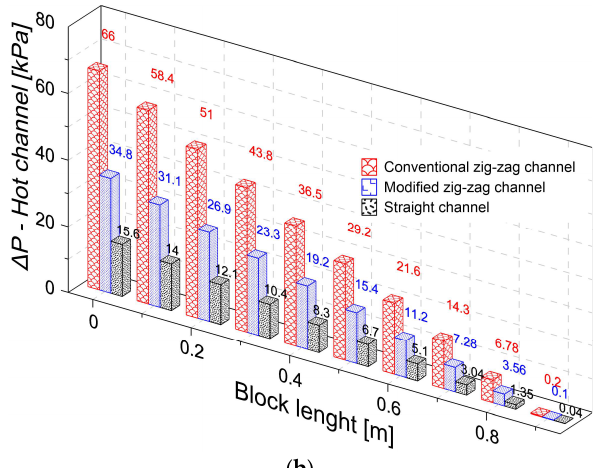
Figure 7. Pressure differential of PCHE blocks: ( a ) cold channel; ( b ) hot channel. Figure 8 shows the change of the friction factor in relation to the Reynolds number for the different channels of the PCHE.